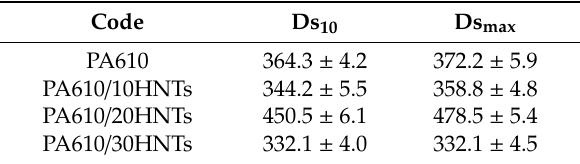
Table 5. Summary of results of the maximum specific optical density values (Ds max ) and at 10 min of testing (Ds 10 ).